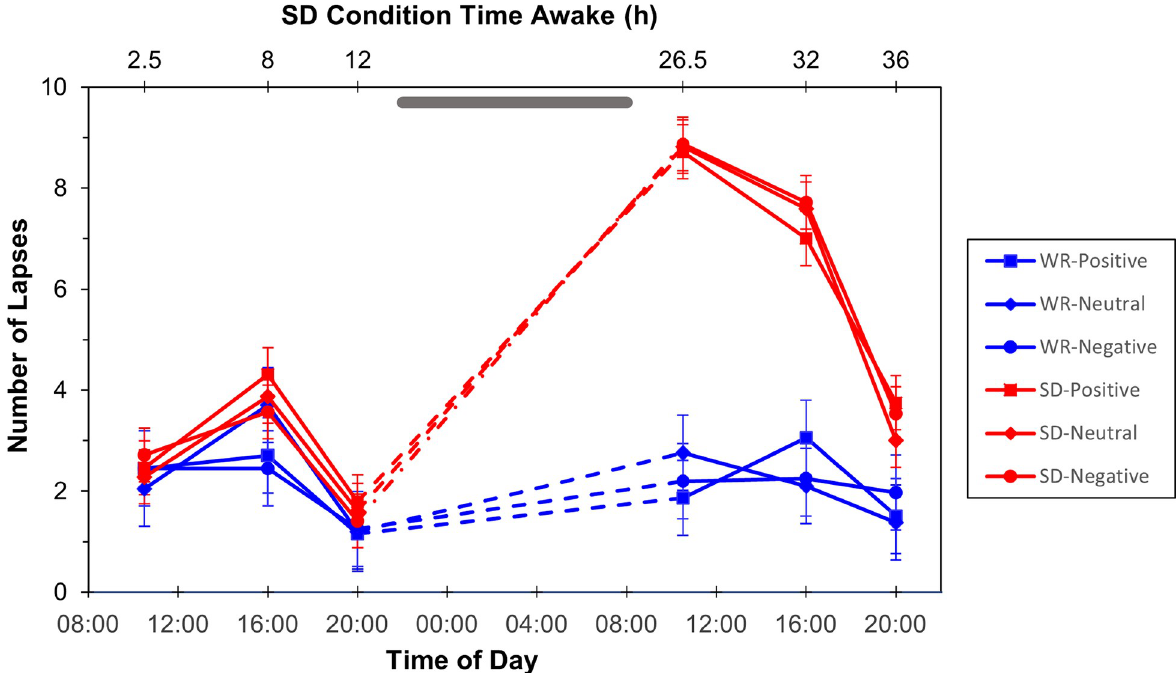
Fig 3. Number of lapses (mean ± SE) on the affective PVT for each category of valenced word stimuli for the TSD (red) and WR (blue) conditions. Grey bar represents sleep opportunity for WR condition and time awake for TSD condition.